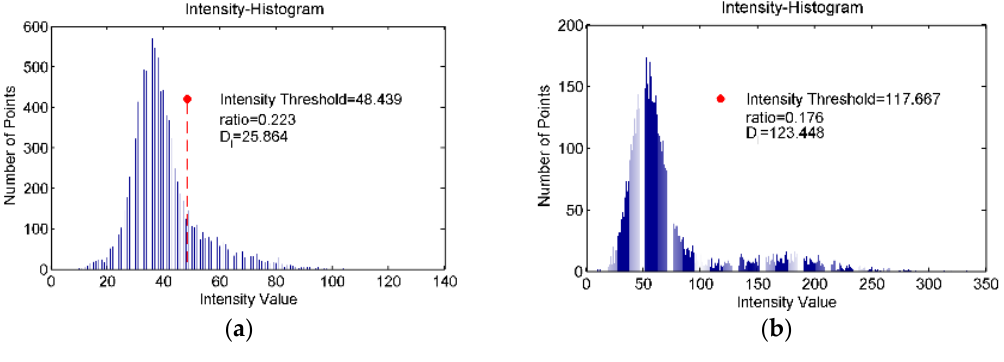
Figure 8. Intensity histogram: ( a ) Rect 1 ; and ( b ) Rect 2 .